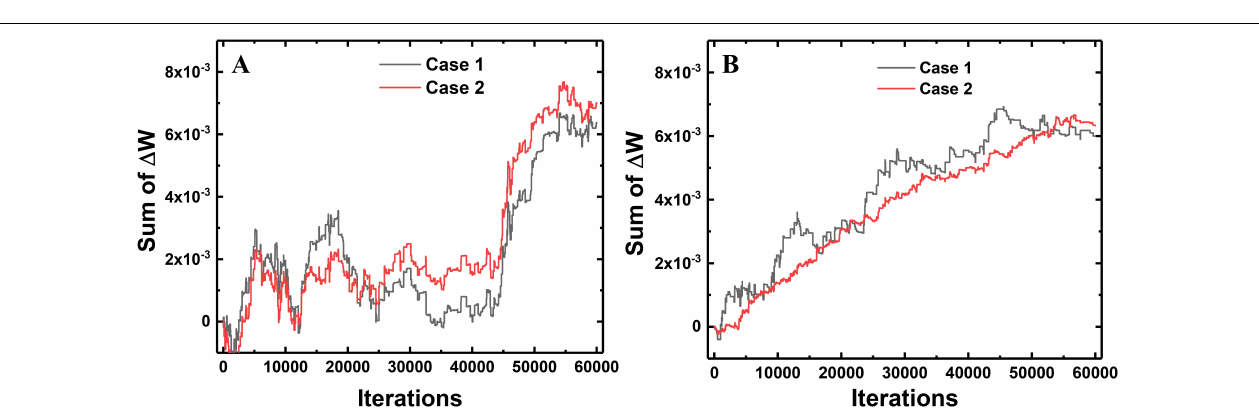
FIGURE 8 | Sum of weight updates in a synapse connecting two adjacent neurons in the 784-256-10 network. (A) Sum of weight updates in the synapse between the 358th neuron as the input layer and the 124th neuron as the hidden layer. (B) Sum of weight updates in the synapse connecting the 97th neuron as the hidden layer and the 5th neuron as the output